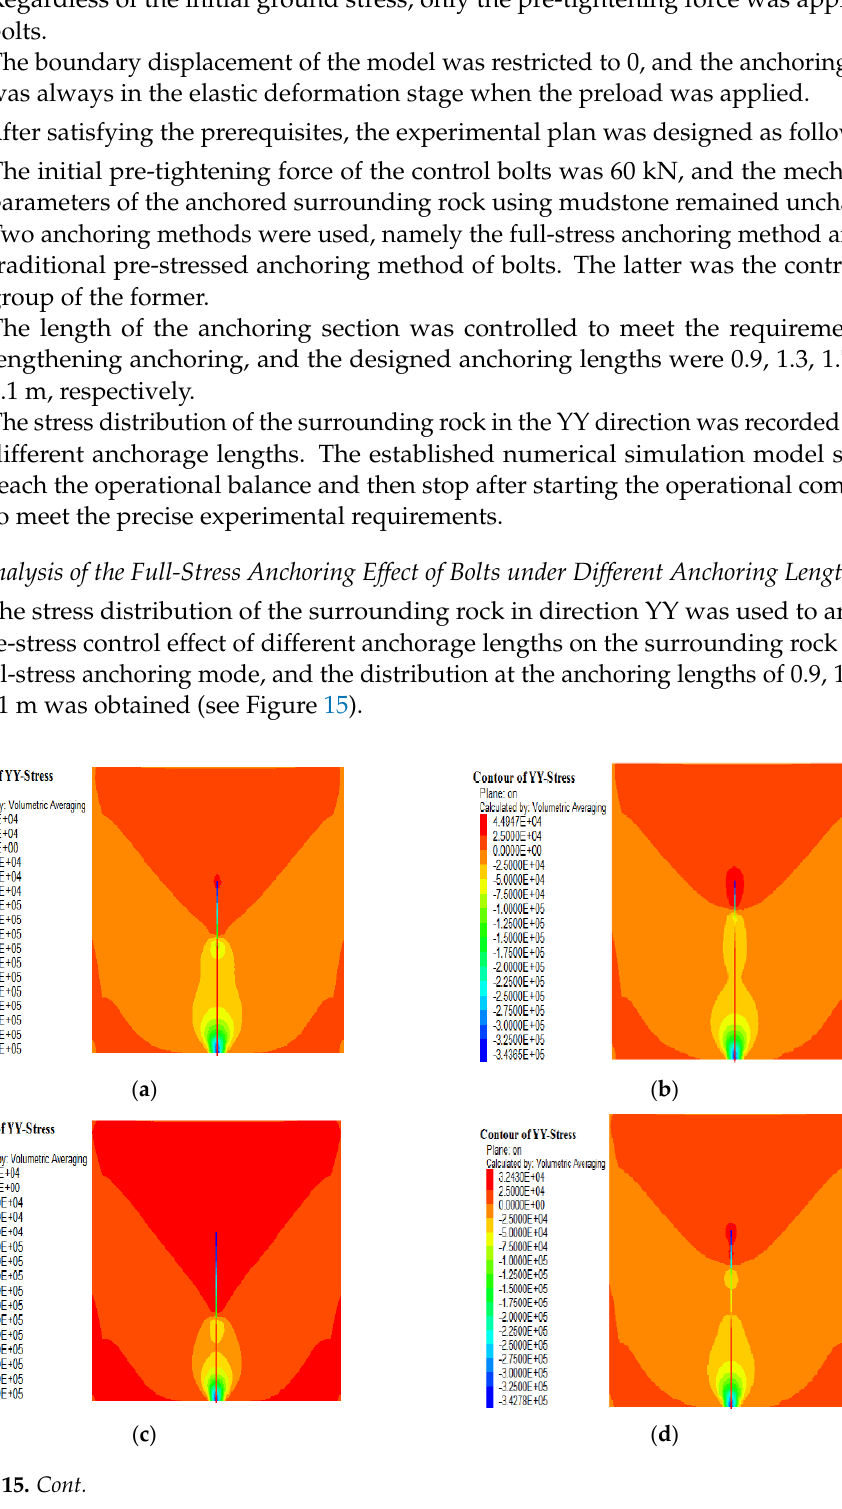
Figure 15. Stress distribution of the surrounding rock at different anchorage lengths under an initial preload of 60 kN. ( a ) With the traditional prestressed anchoring method at an anchorage length of 0.9 m; ( b ) with full stress anchoring method at an anchorage length of 0.9 m; ( c ) with the traditional prestressed anchoring method at an anchorage length of 1.3 m; ( d ) with full stress anchoring method at an anchorage length of 1.3 m; ( e ) with the traditional prestressed anchoring method at an anchorage length of 1.7 m; ( f ) with full stress anchoring method at an anchorage length of 1.7 m; ( g ) with the traditional prestressed anchoring method at an anchorage length of 2.1 m; ( h ) with full stress anchoring method at an anchorage length of 2.1 m. According to the comparison test of traditional pre-stressed anchoring and full- stressed anchoring of bolts with four groups at the anchoring lengths of 0.9, 1.3, 1.7, and 2.1 m in Figure 15, the following conclusions can be drawn: